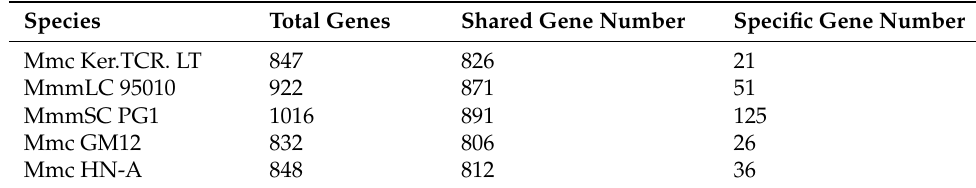
Table 6. Specific genes of five Mycoplasma mycoides strains.